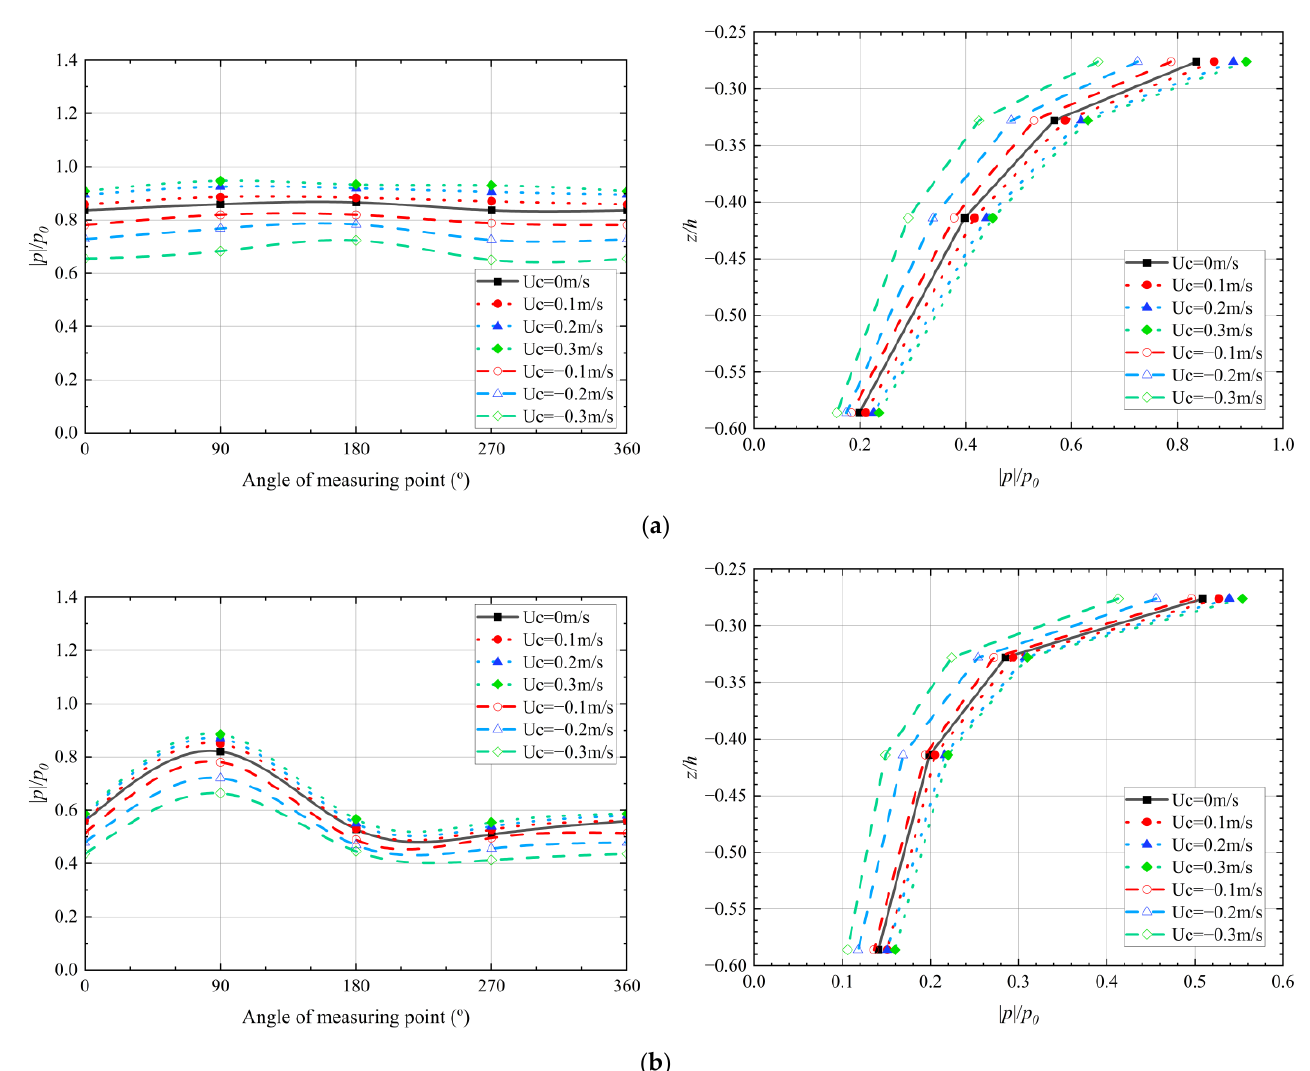
Figure A5. Variation of the dimensionless pore pressure amplitude around the pipeline with differ- ent backfill depths within the medium sand and silt seabed. ( a ) 𝑑 50 = 0.30 mm; ( b ) 𝑑 50 = 0.045 mm.